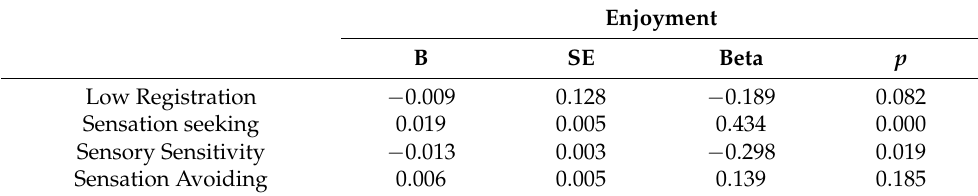
Table 4. Regression analysis results for AASP scores as predictors of